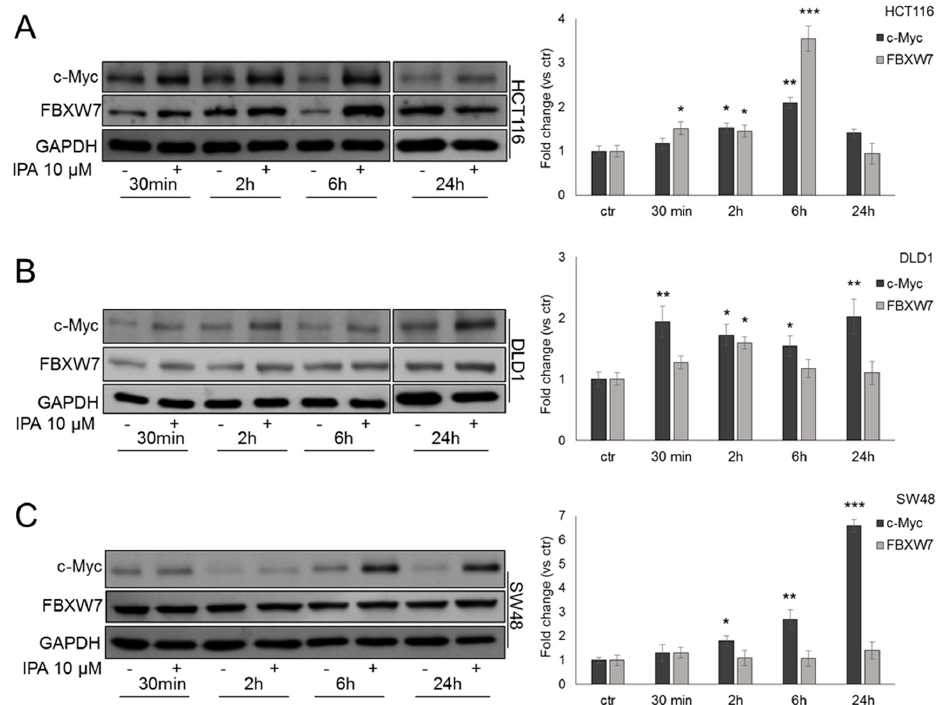
Figure 2. IPA modulates FBXW7 and c-Myc expression. Representative western blot and relative densitometry analysis (histograms on the right) of FBXW7 and c-Myc protein expression in HCT116 ( A ), DLD1 ( B ) and SW48 ( C ) cells, treated with IPA at the indicated time points. Blots are representative of at least five independent experiments. Data are expressed as mean ± SD of five independent experiments. * p < 0.05, ** p < 0.01, *** p < 0.005 vs. control.